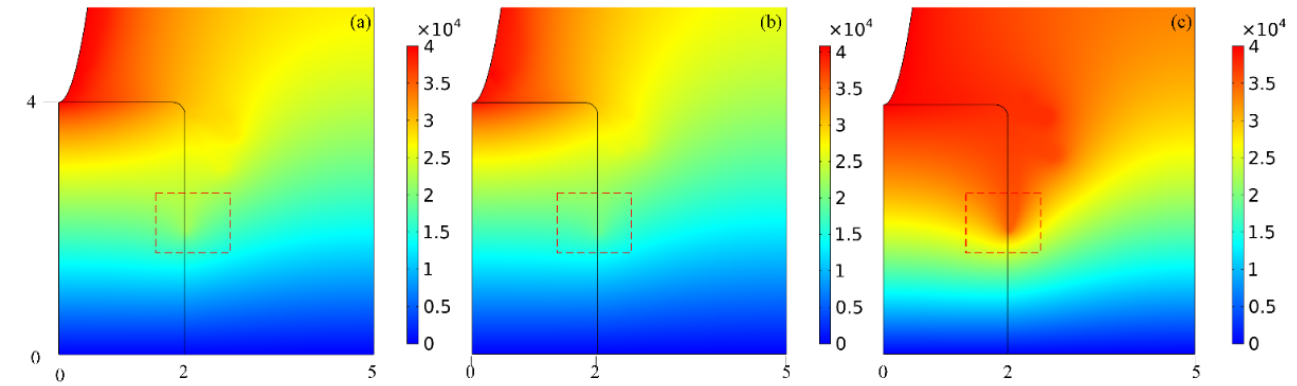
Figure 10. The potential (V) distribution of streamer development to 20 mm from the plane electrode: ( a ) model A; ( b ) model B; ( c ) model C; (The red dotted lines are the location of the streamer head); the scale unit is millimeters (mm).